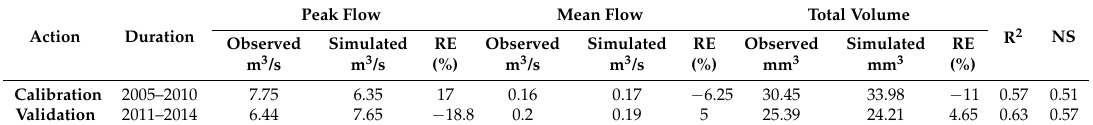
Table 2. Model performance during calibration and validation periods.